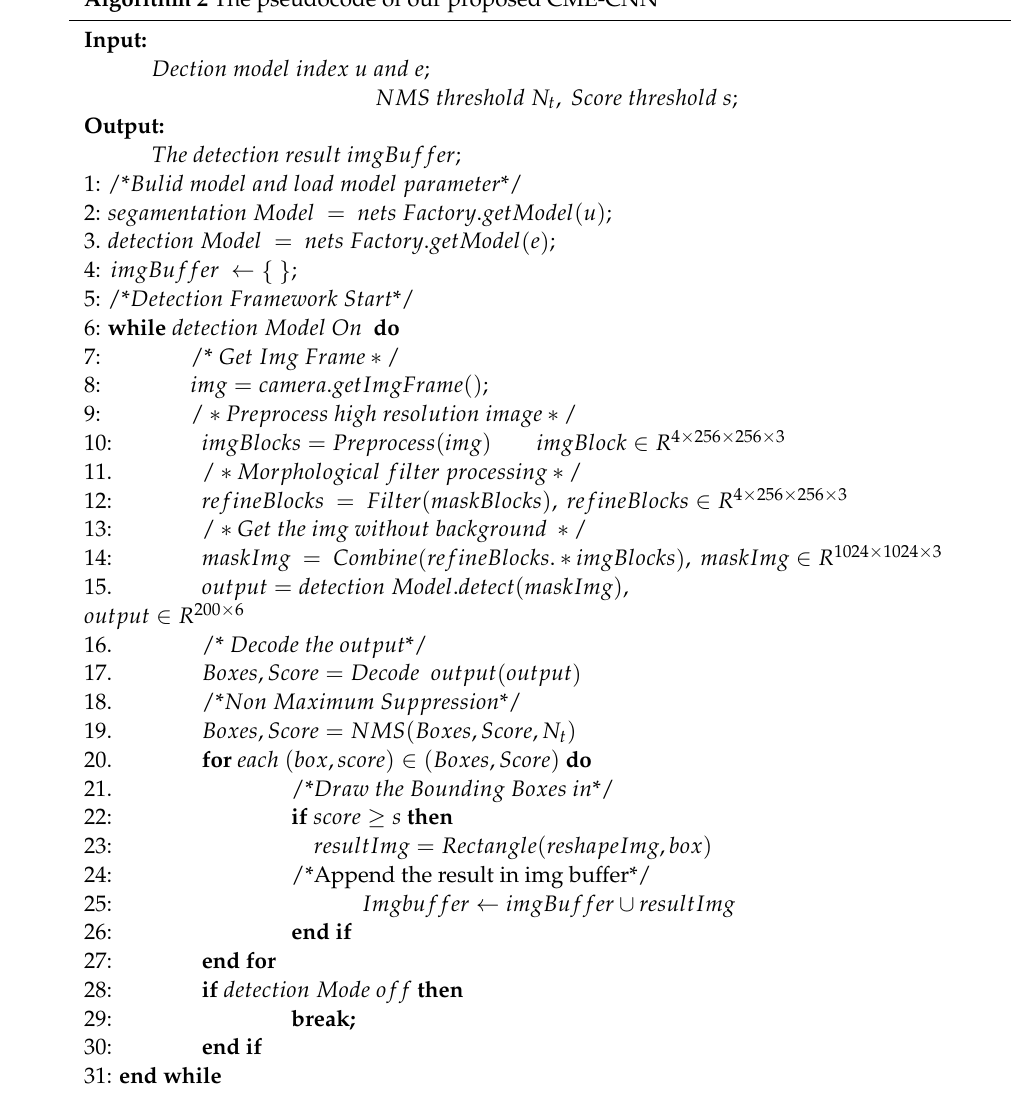
Algorithm 2 The pseudocode of our proposed